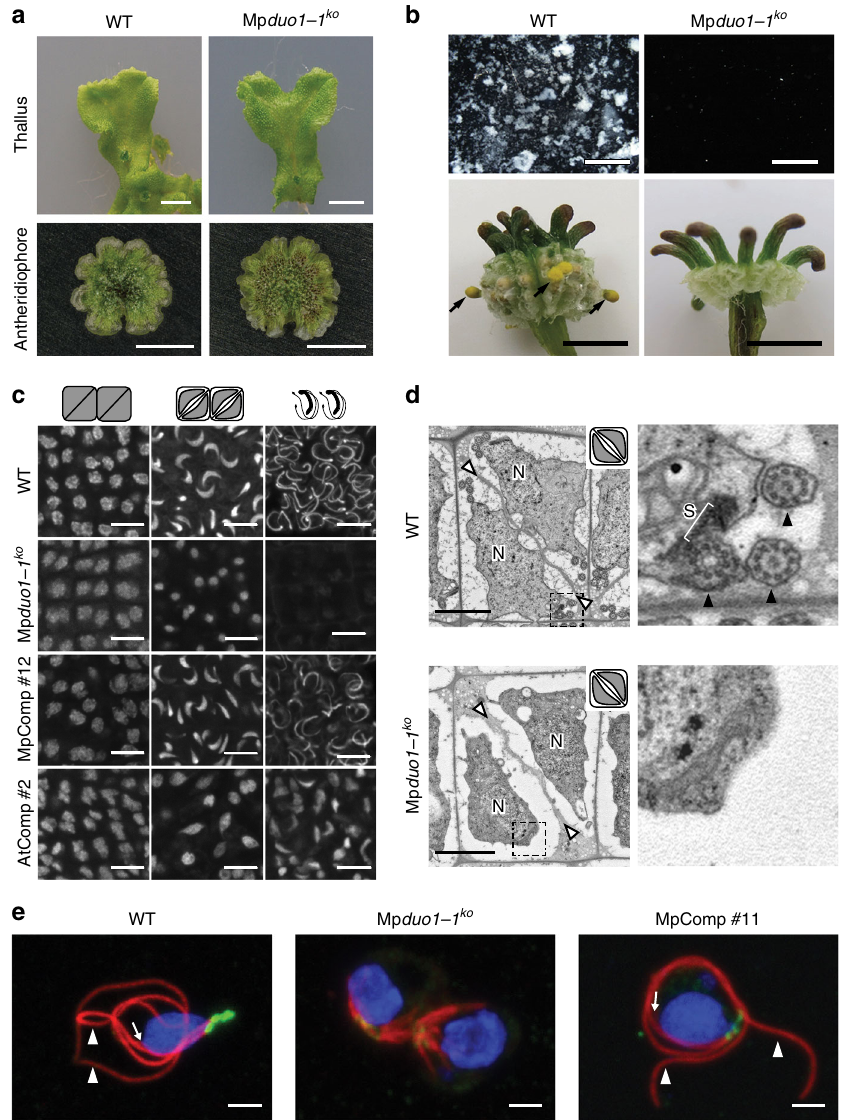
Fig. 2 Mp duo1-1 ko shows defects in sperm morphogenesis. a Images of thallus (top) and antheridiophore (bottom) of WT (left) and Mp duo1-1 ko (right). b Top panels show sperm masses (white) discharged from mature antheridiophores into water in WT but not in Mp duo1-1 ko . Bottom panels show the production of yellow sporangia (black arrows), which mark successful fertilization, on female WT about a month after crossing with male WT, but no sporangia production in crosses with male Mp duo1-1 ko . c Feulgen staining of spermatids during spermiogenesis in WT, Mp duo1-1 ko , and Mp duo1-1 ko complemented by Mp DUO1 genomic fragment (MpComp) and by pro Mp DUO1 :At DUO1 (AtComp). d Transmission electron micrographs of spermatids. White arrowheads indicate cell boundaries and N indicates nucleus. Areas in the dashed line boxes are enlarged in the right panels and show that the spline (S), a microtubular backbone-like structure, and fl agella (black arrowheads) are present in WT but missing in Mp duo1-1 ko . e Localization of centrins (green) and tubulins (red) in differentiating spermatids of WT, Mp duo1-1 ko (the panel shows two sister cells), and MpComp. Centrin signals mark two basal bodies and an associated multi-layered structure. The blue signals indicate the DAPI stained nuclei. White arrowheads and arrows indicate fl agella and spline, respectively. Scale bars, 5 mm ( a ), 400 μ m ( b , top), 5 mm ( b , bottom), 5 μ m ( c ), and 2 μ m ( d , e